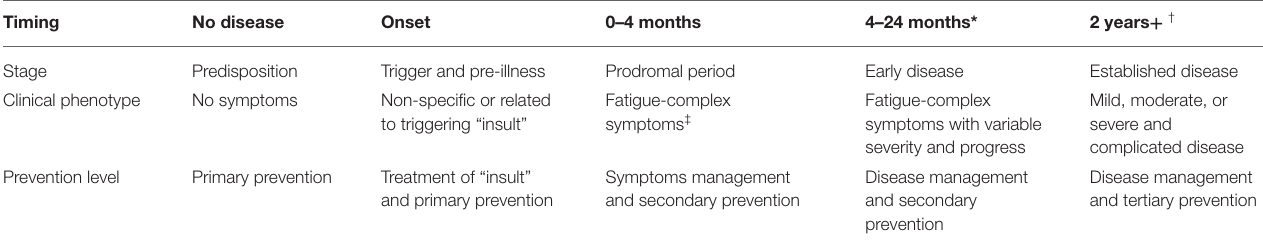
TABLE 1 | Characterisation of ME/CFS progression on time, according to distinct stages from pre- to established, clinical phenotype, and levels of prevention.